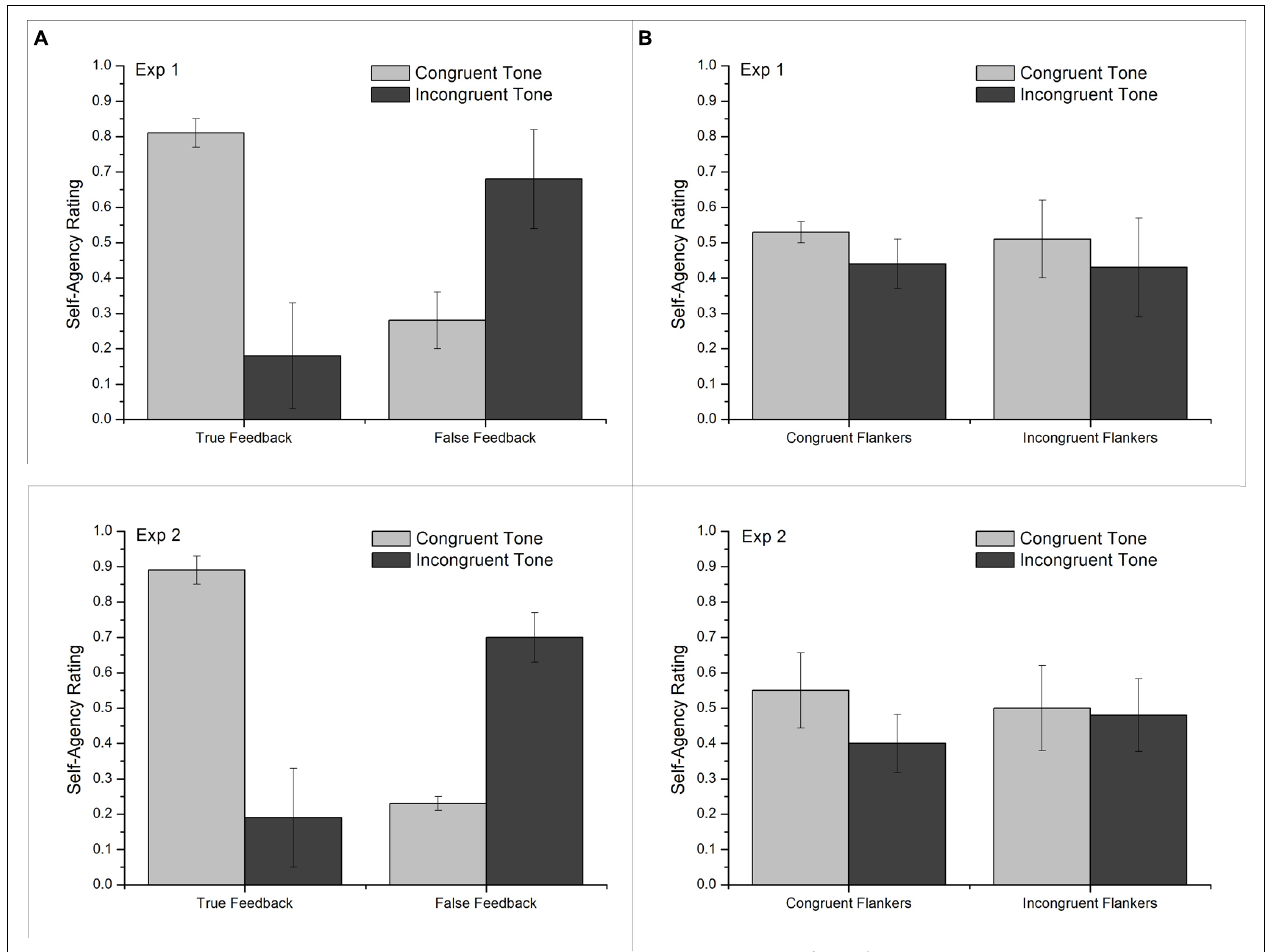
FIGURE 2 | Sense of self-agency calculated from discrete scale (e.g.,Yes, No, or Maybe) in Experiment 1 (top panels) and Experiment 2 (bottom panels). Standard deviations are plotted as error bars. (A) Average self-agency rating in true and false feedback conditions. (B) Average self-agency rating in congruent and incongruent